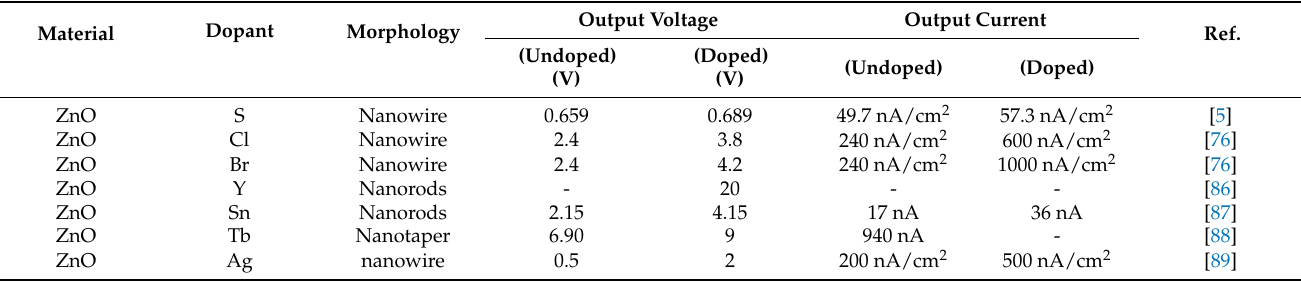
Table 2. Examples of piezoelectric materials with different